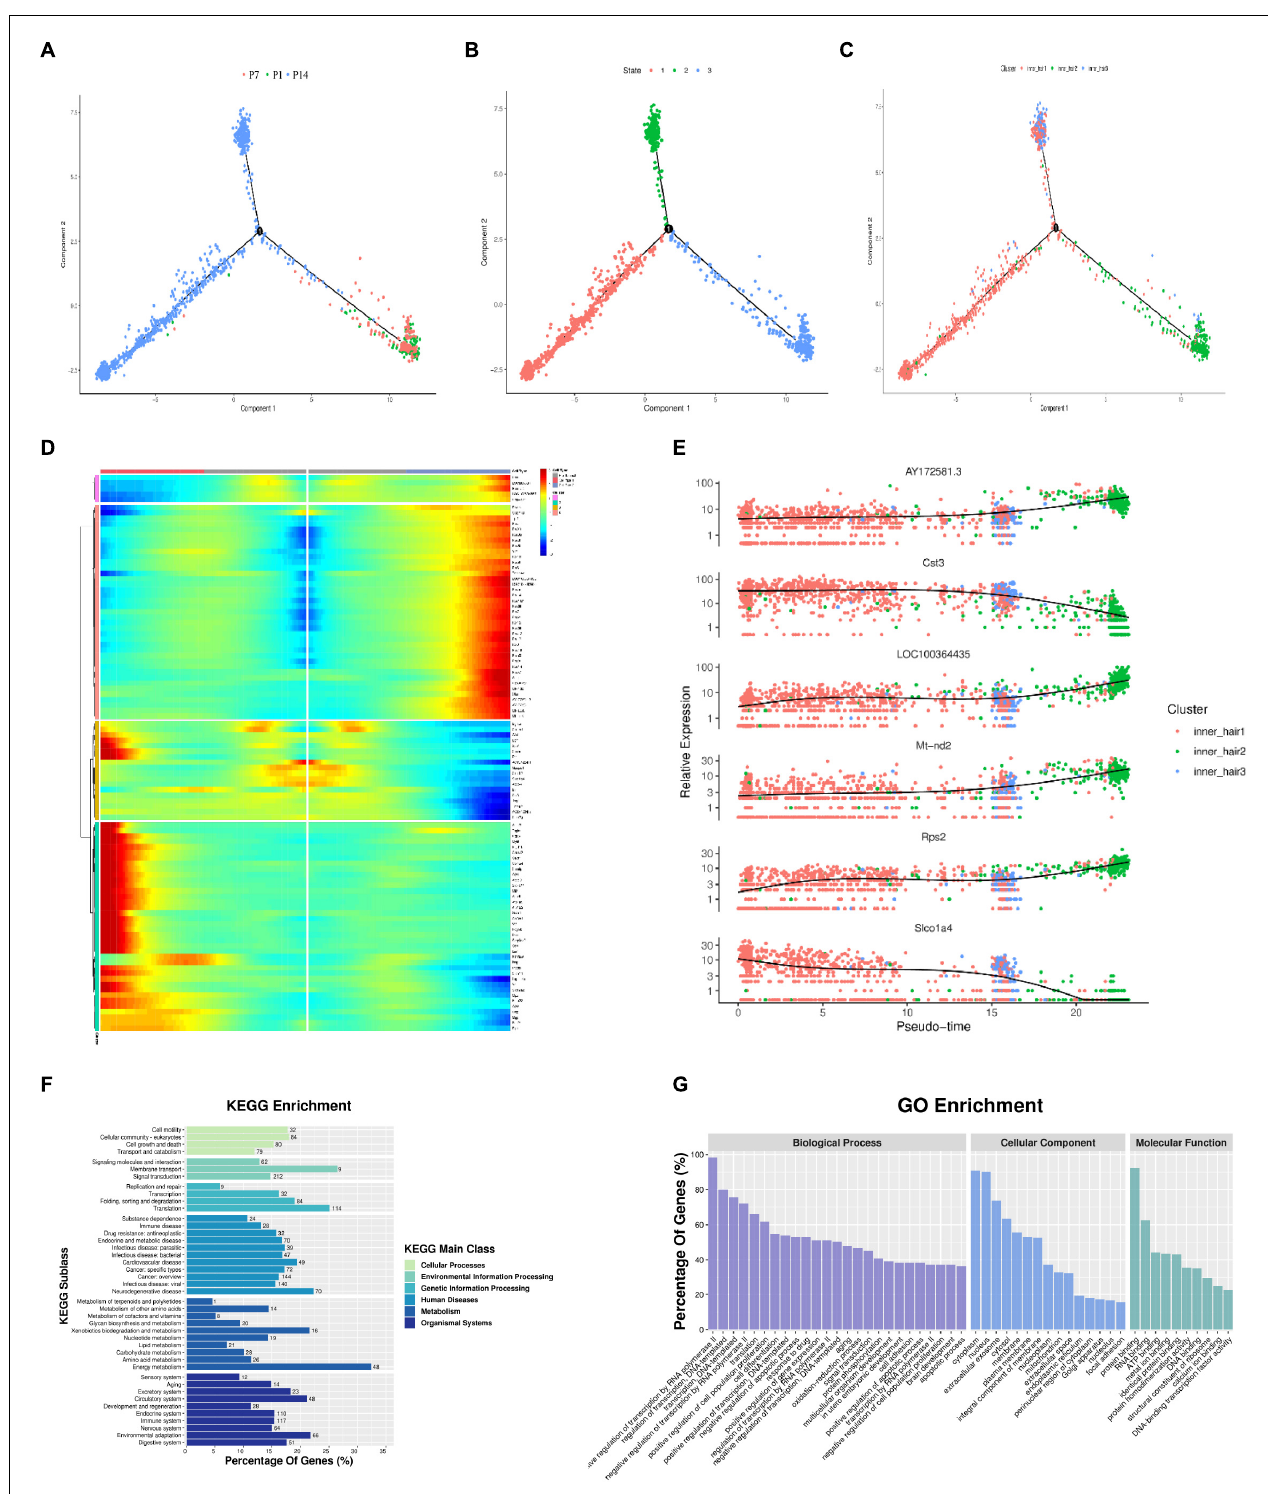
FIGURE 6 | Pseudotime trajectory of the inner hair cell. (A–C) Monocle analyses show the development of inner hair cells at different cell developmental periods (A) , developmental states (B) , and branches of development (C) . (D) Heatmap of DEGs in different blocks along the pseudotime trajectory. The Red color represents an abundant expression of genes. (E) Dynamic gene expression with pseudotime trajectory. (F) GO enrichment analysis of genes in cells through fate 1 and fate 2. (G) Functional enrichment analyses with KEGG performed with the enriched genes in cells through fate 1 and fate 2.